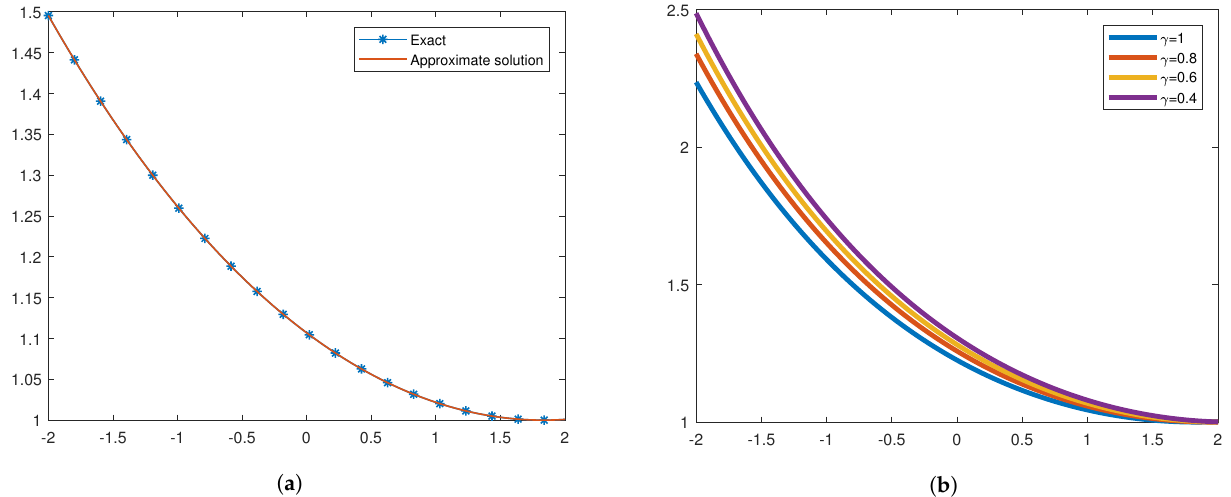
Figure 6. ( a ) Exact and approximate solution plot of example 2. ( b ) Approximate solution plot of different fractional of γ = 1 of example